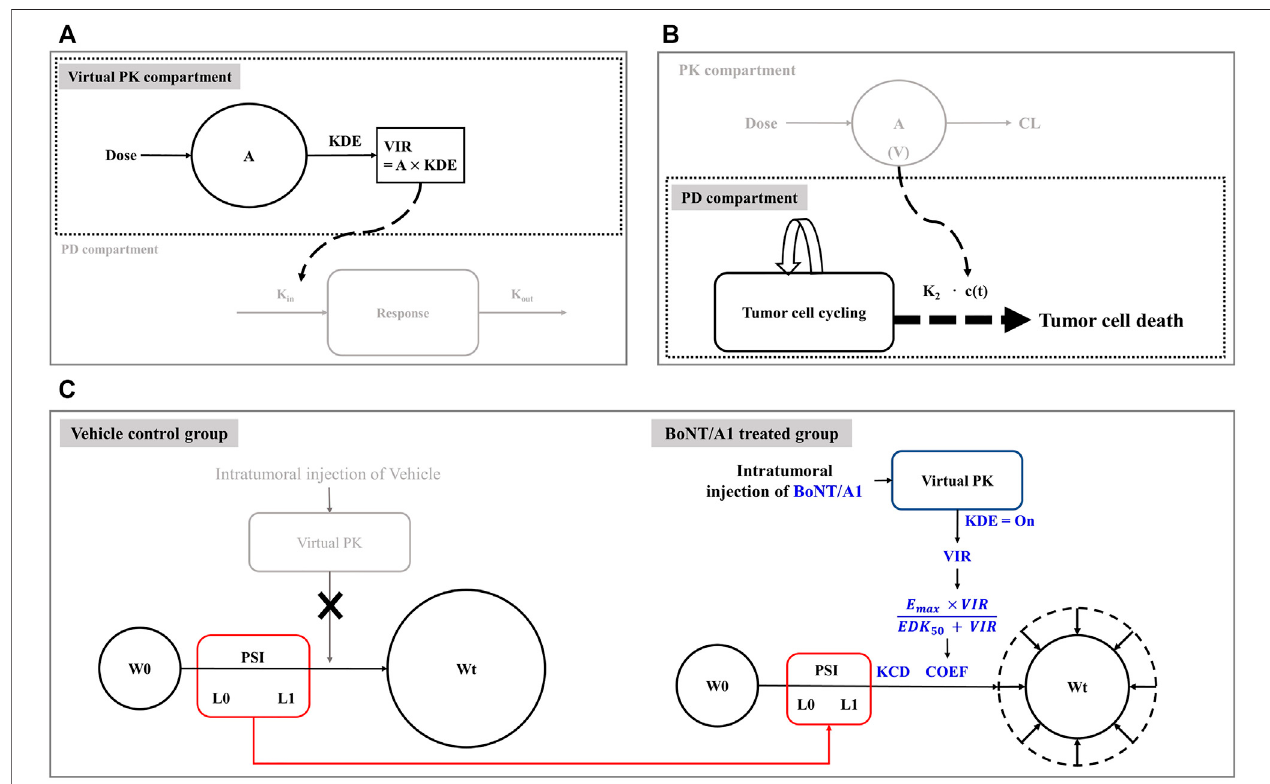
FIGURE 1 | Model structures related to this study. (A) Typical K-PD model structure. (B) Simeoni ’ s tumor growth inhibition model structure. (C) Final K-PD model structure.